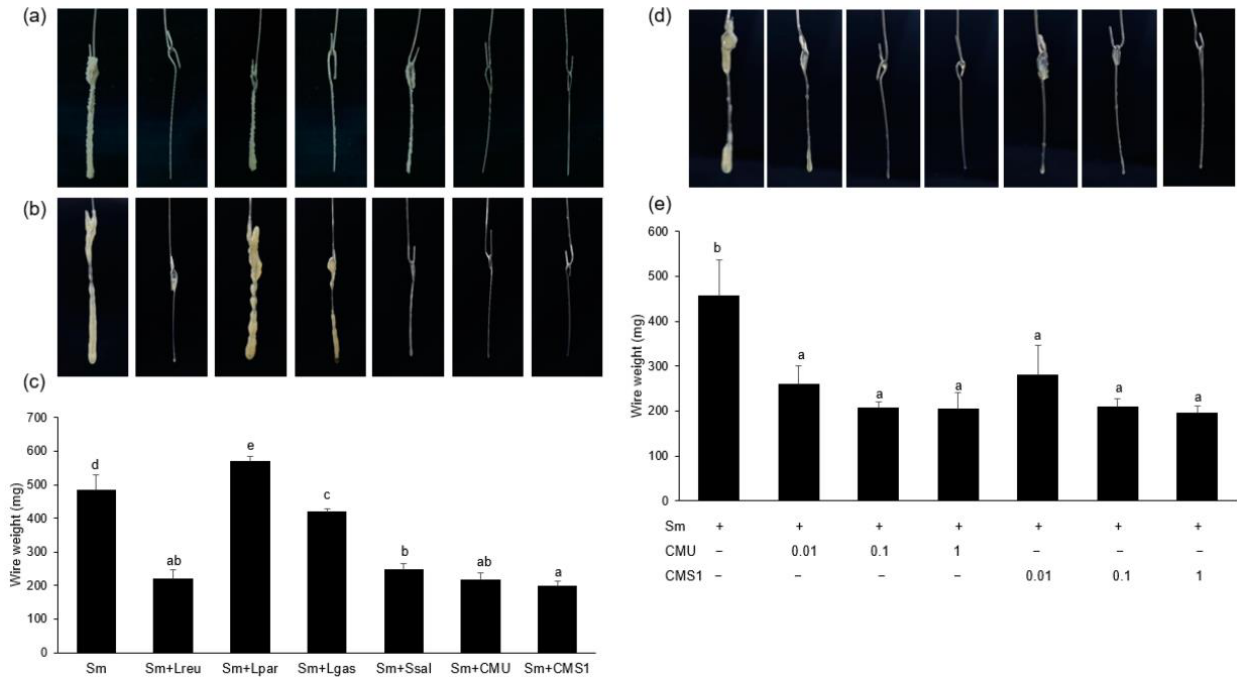
Figure 1. Effect of oral probiotics on biofilm formation by S. mutans KCTC 3065 ( a ) or S. mutans Ingbritt ( b ) on orthodontic wires. ( c ) Comparison of biofilm weight. ( d ) Dose-dependent effects of W. cibaria CMU and CMS1. ( e ) Comparison of biofilm weight according to the dose-dependent effects of W. cibaria CMU and CMS1. Sm, S. mutans Ingbritt; Lreu, L. reuteri ; Lpar, L. paracasei ; Lgas, L. gasseri ; Ssal, S. salivarius ; CMU, W. cibaria CMU; CMS1, W. cibaria CMS1. Data are presented as the mean ± standard deviation. Different letters indicate significant differences at p < 0.05. Table 1. Effects of oral probiotics on the growth of S. mutans under tube wire test conditions. Group S. mutans (CFU/mL) Reduction (Log CFU/mL) % Growth Inhibition S. mutans